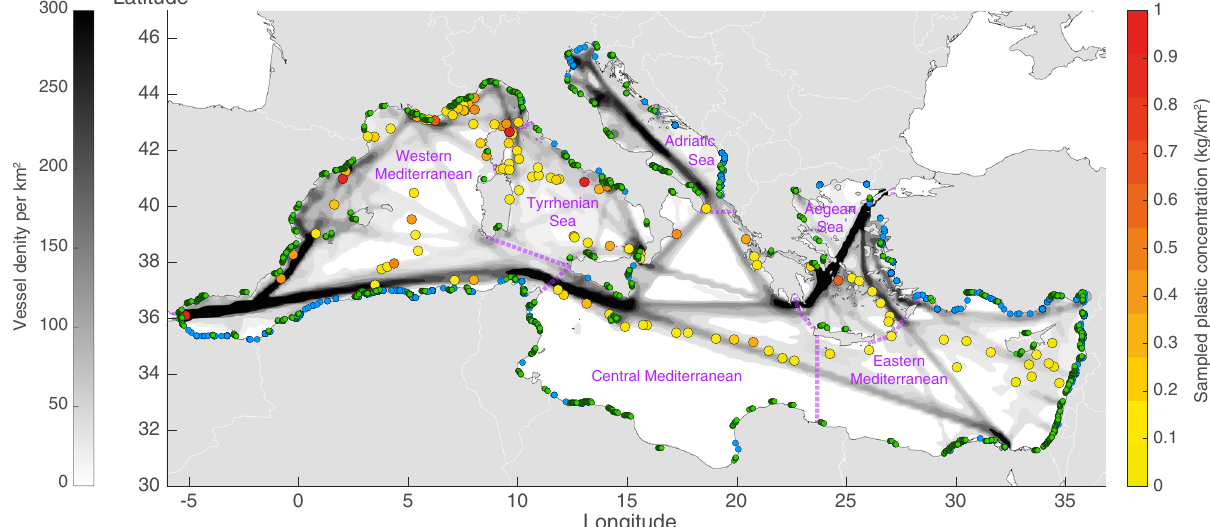
Fig. 1 Overview of the domain analysed. Colored circles show the locations of the 122 Tara Expedition stations and the plastic concentrations measured there (right-hand yellow-to-red scale bar) 16 . The green and blue dots near the shore indicate the positions of the coastal cities and river mouths, respectively, used in the model as land sources of plastic. The basin gray scale shows the vessel density (left-hand scale bar), which was used to determine the proportion of plastic debris directly released at sea by vessels. Purple dashed lines separate the different